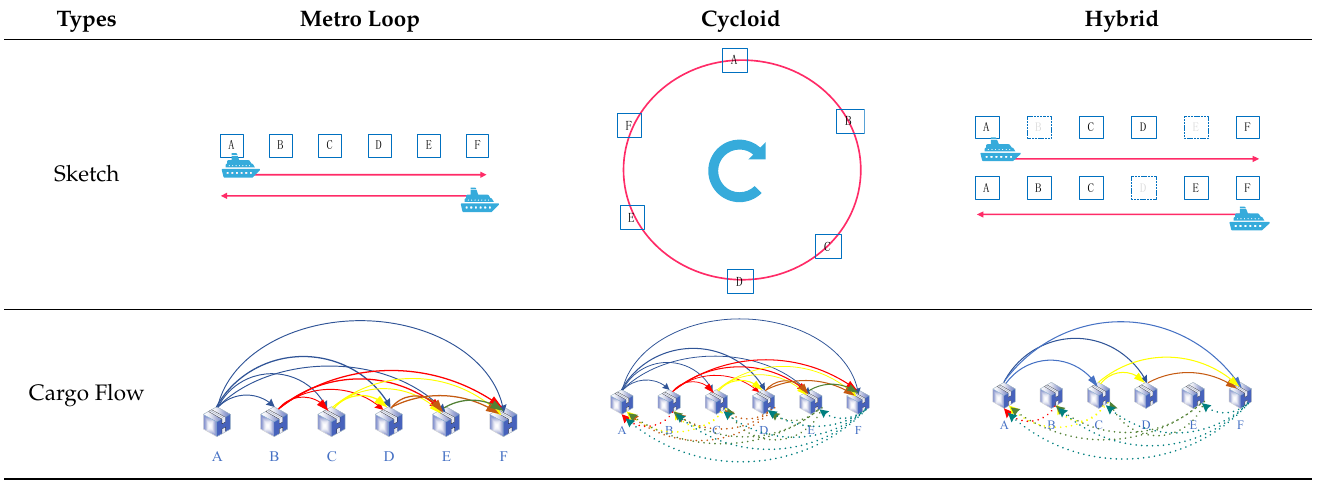
Table 1. Types of containership stowage plans for full routes.